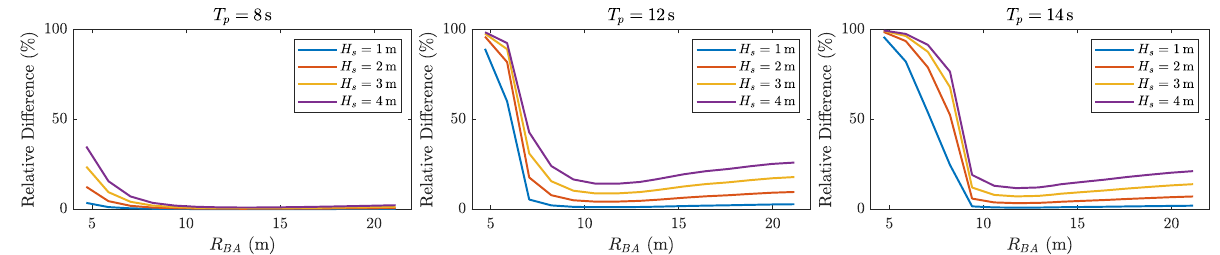
Figure 12. Percentage difference between wave power generated for model with and without viscous drag as a function of R BA . Individual plots vary in terms of T p (as per the titles) and curves display varied H s (as per the legend). Results are taken under conditions with D BA / R BA = 1.00, ∆ x = 50m, and L k = L b =